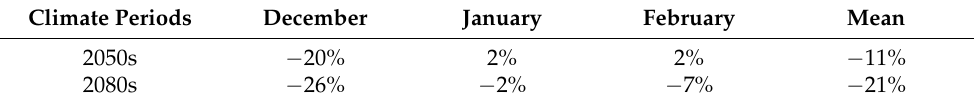
Table 3. River discharge prediction (%) in the study region for the mid and end-century. Climate Periods